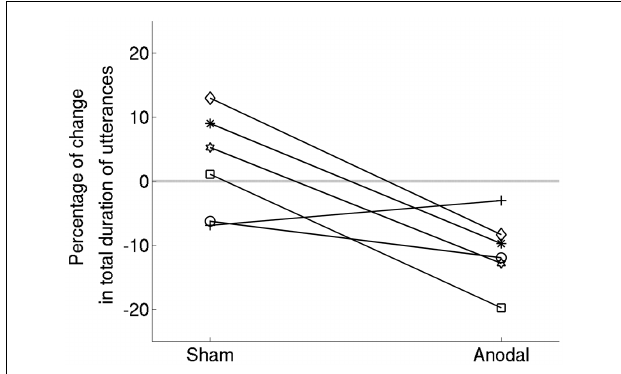
FIGURE 3 | Data shown separately for each participant. The trend for all but one participant is in the direction of greater improvement in the anodal -tDCS condition compared to sham